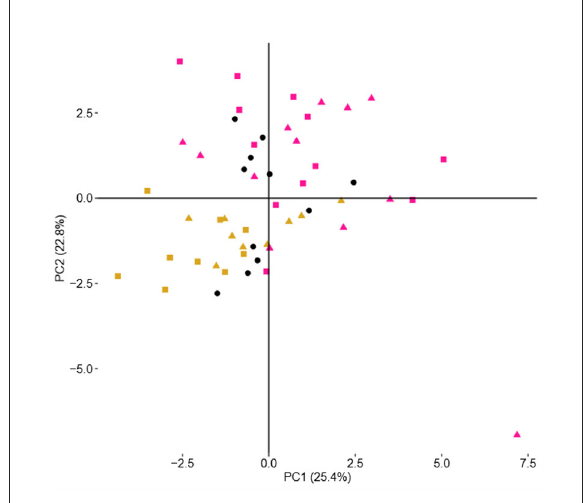
FIGURE5 Scores plot of a two-component PCoA model of NMR spectra showing sample clustering according to ingredient addition: CTRL cheeses (black circles), BB cheeses (yellow), and CC cheeses (pink). Squares are for the addition of 0.6% and triangles for the addition of 0.3% of the